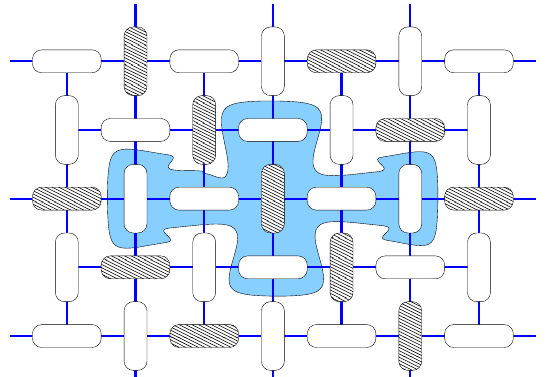
Figure 3: A schematic representation of the stripe 1 / 3-plateau phase and a hard- core repulsion condition for triplons. Dashed (empty) rounded rectangles denote S z = 1 triplet (singlet) states on dimers. The blue shaded area indicates a hard-core constraint for a central dimer in a triplet state, which excludes triplons on all its four nearest-neighbor dimers as well as two alike oriented further-neighbor dimers along one spatial